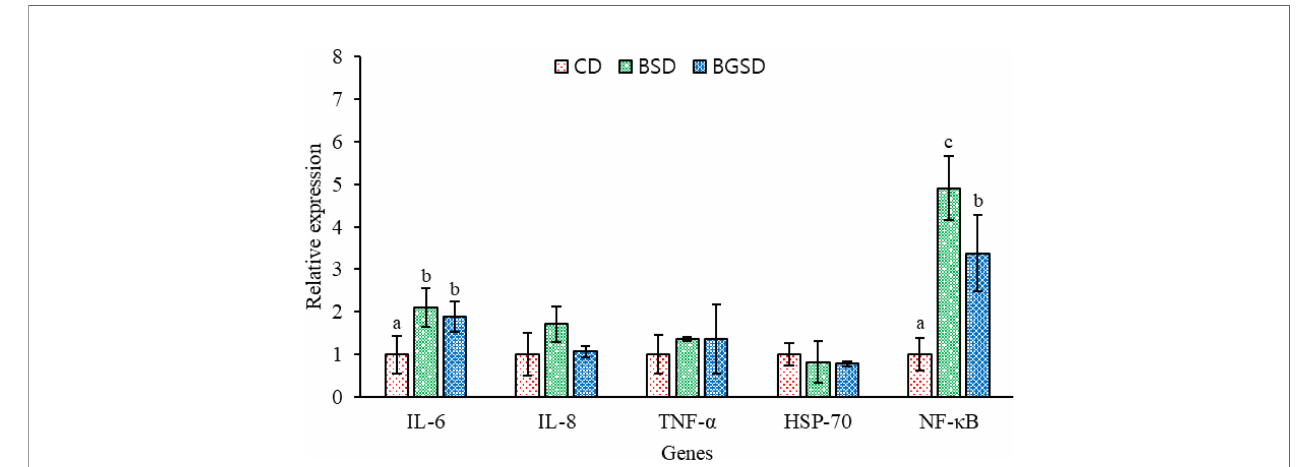
FIGURE 7 | Pro fi les of immune-related gene expression in the intestine of red sea bream. The expression of these genes was measured in the CD, BSD, and BGSD groups by RT-qPCR after 8 weeks of feeding. The gene expression levels were quanti fi ed relative to b -actin transcription. The data are represented as the means ± standard deviation; different letters indicate signi fi cant differences between groups ( P < 0.05). Control diet, CD: without Bacillus sp. PM8313 or b -glucan, BSD: 1 × 10 8 CFU g − 1 Bacillus sp. PM8313, and BGSD: BSD + 0.1% b -glucan.